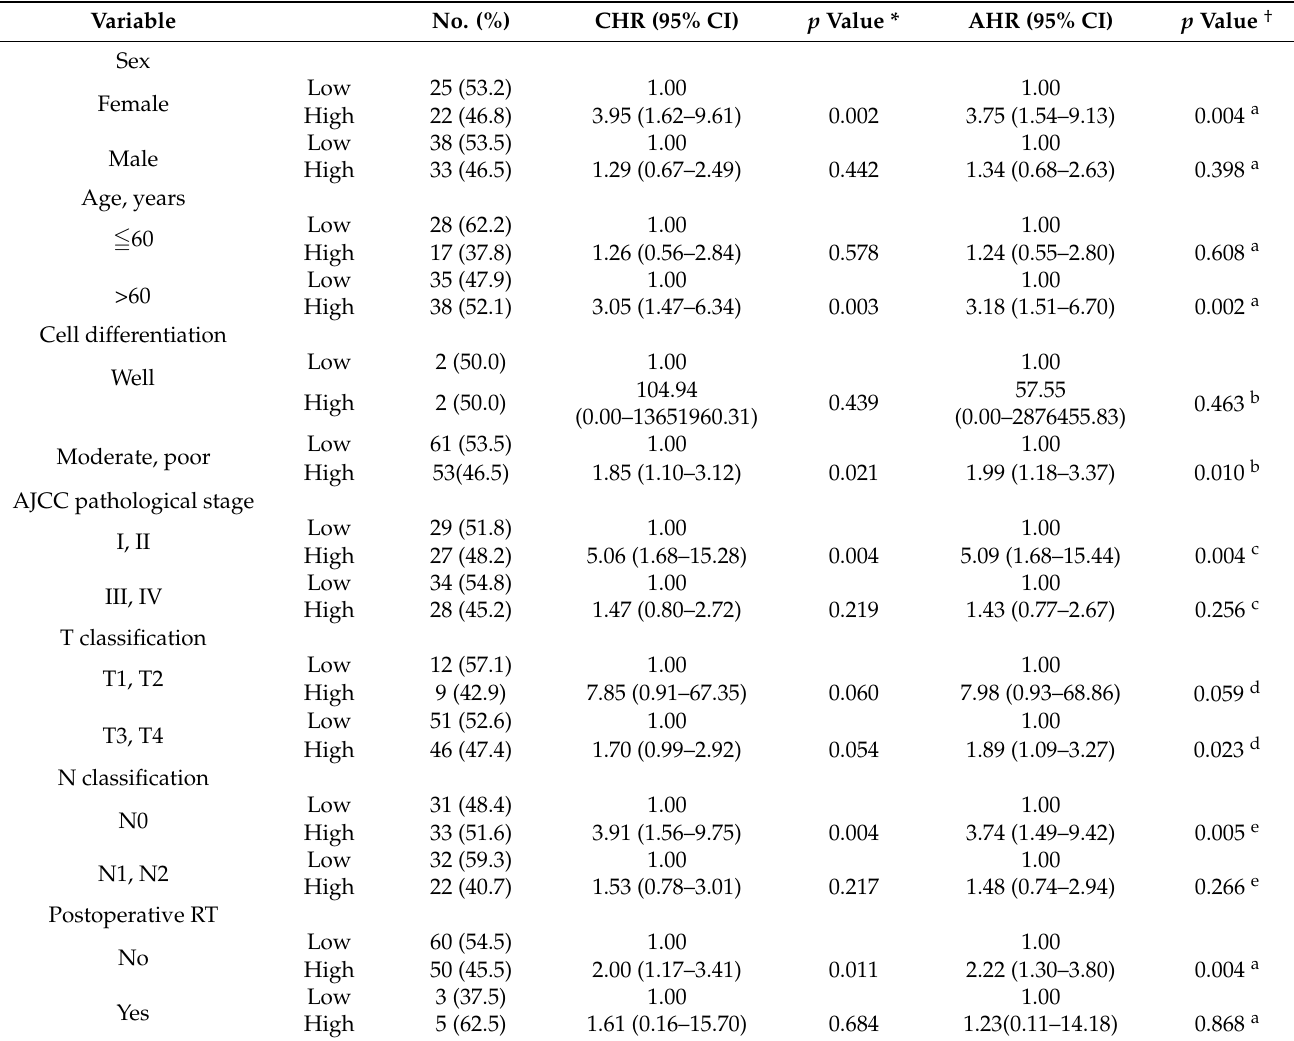
Table 3. Association of the ATG5 protein level on disease-free survival according to demographic and clinicopathologic factors in CRC